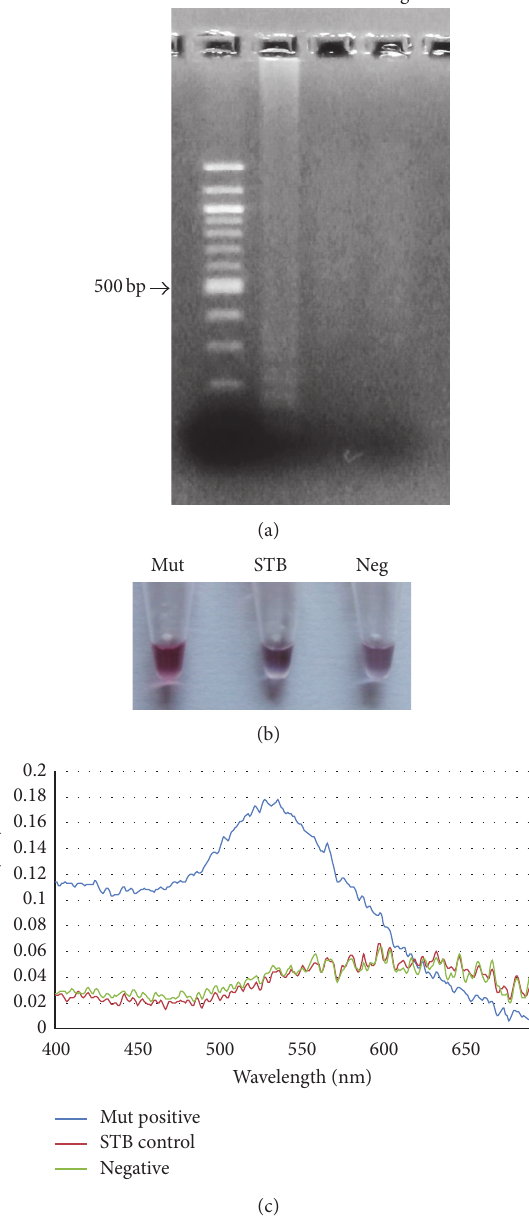
Figure 6: Au-nanoprobe colorimetric assay. (a) Agarose gel show- ing LAMP products. Lane 1, M: Ladder DNA marker; Lane 2: Mut (MDR-TB), Lane 3: STB (Standard strain H37RV), and Lane 4: Neg (negative). (b) Corresponding results recorded visually after salt challenge. (c) UV-Vis spectra of the respective